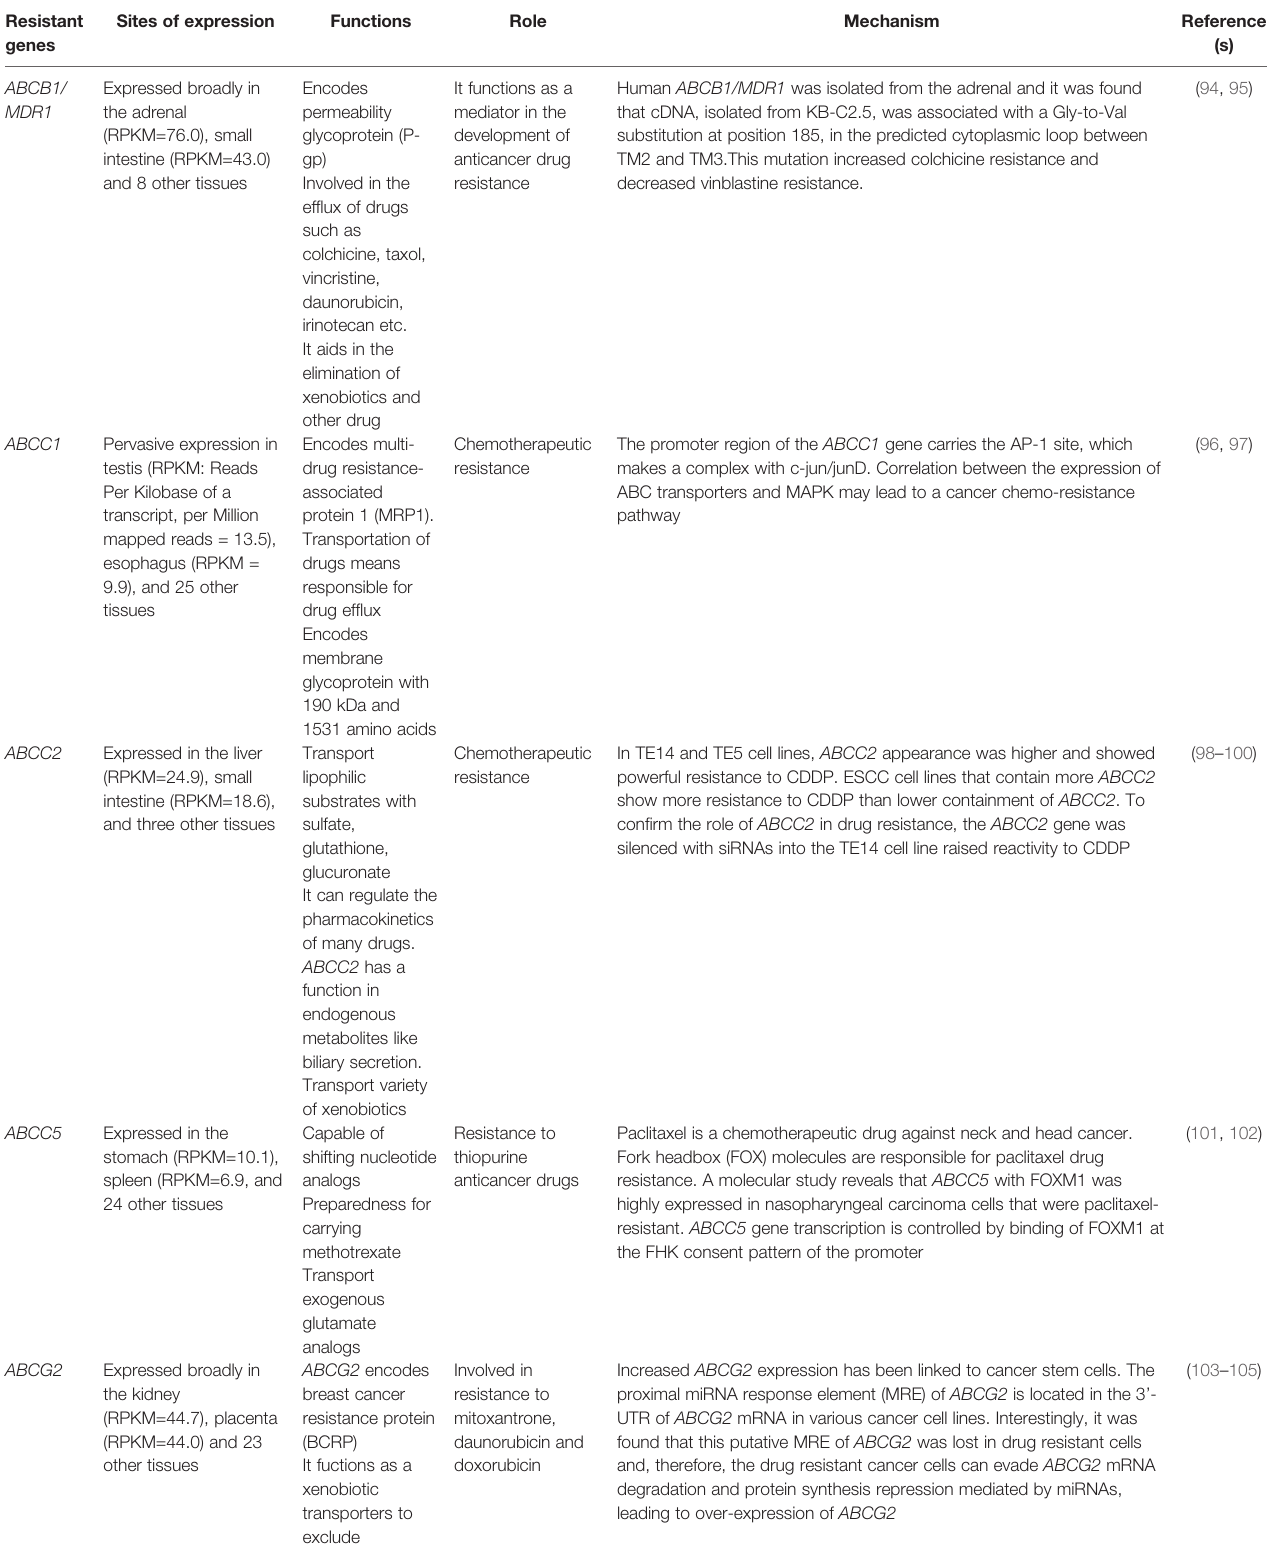
TABLE 1 | Key molecular function and mechanism of gene expression of resistance genes. Resistant Sites of genes